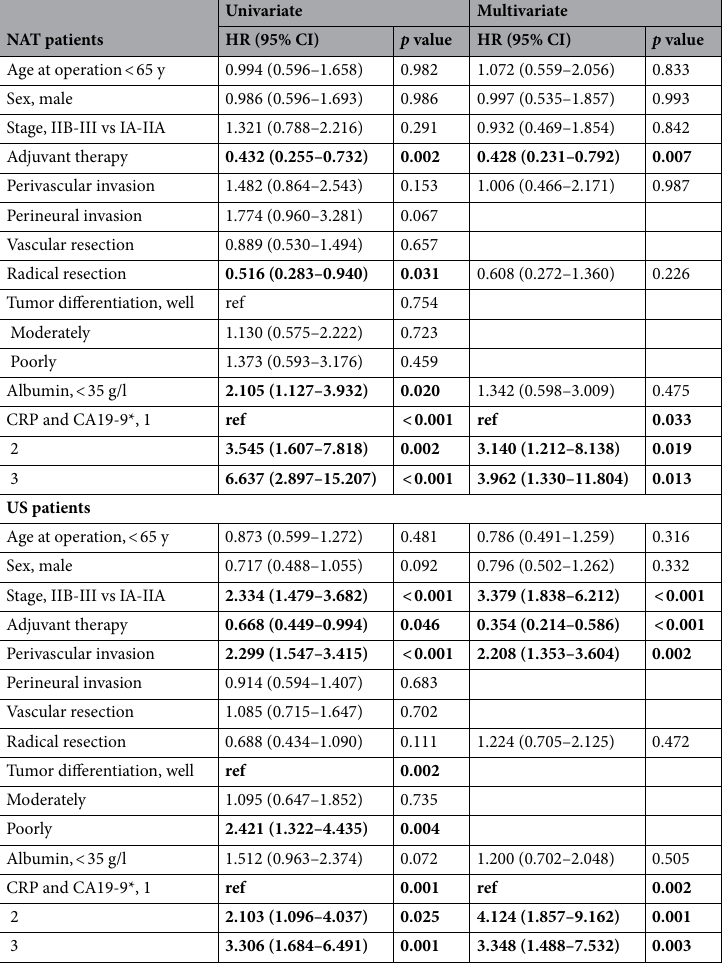
Table 3. Univariate and multivariate analysis for NAT patients and those undergoing upfront surgery separately. The end-point was disease-specific death. *CRP and CA19-9: (1) both CRP and CA19-9 below cut- off value (3 and 37, respectively), (2) either CRP or CA19-9 above the cut-off value, and (3) both values above the cut-off value. The multivariate model was stratified by grade. NAT neoadjuvant therapy, US upfront